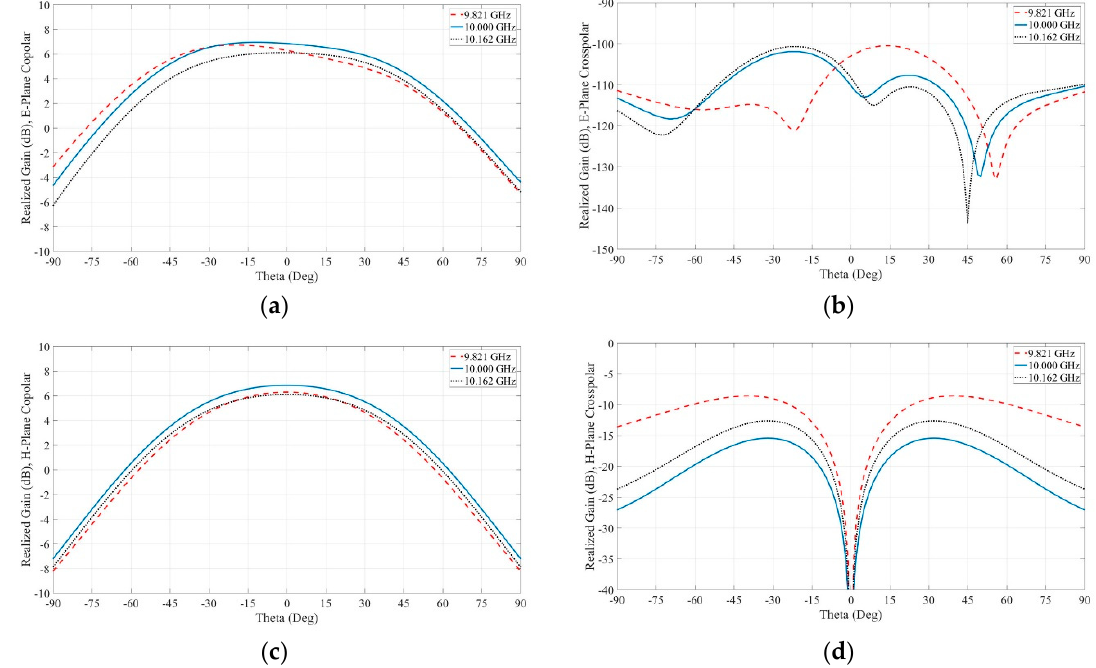
Figure 6. MPA2 radiation pattern: ( a ) E-plane copular, ( b ) E-plane crosspolar, ( c ) H-plane copular, ( d ) H-plane crosspolar.